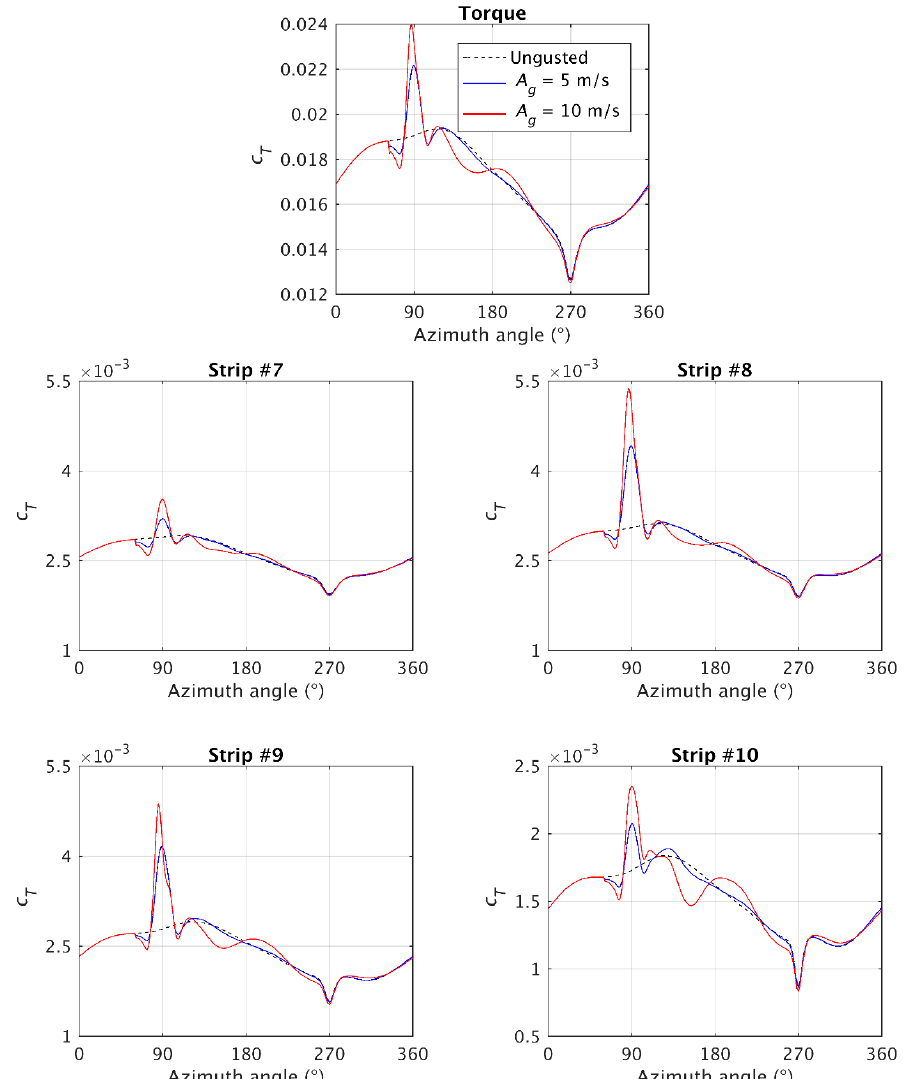
Figure 16. The 1 + cos gusts: ( top ) total aerodynamic torque over the blade hit by the gust as a function of its azimuth angle and ( bottom ) torque contribution of the four most outboard strips.